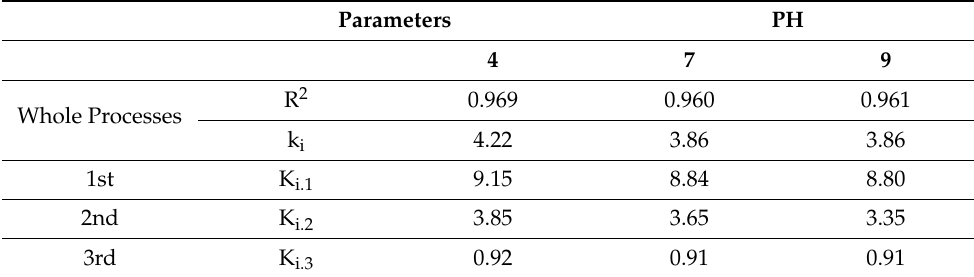
Table 4. Parameters of intraparticle diffusion model using different pH for adsorption of CR dye onto UCs.